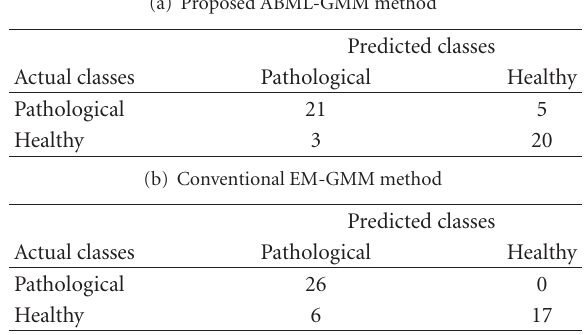
Table 3: Confusion matrix for defined binary classification task.